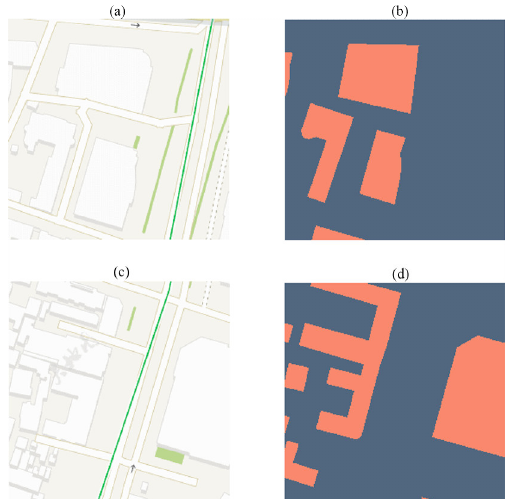
Figure 3 Extract single building layer tiles from raster tiles.